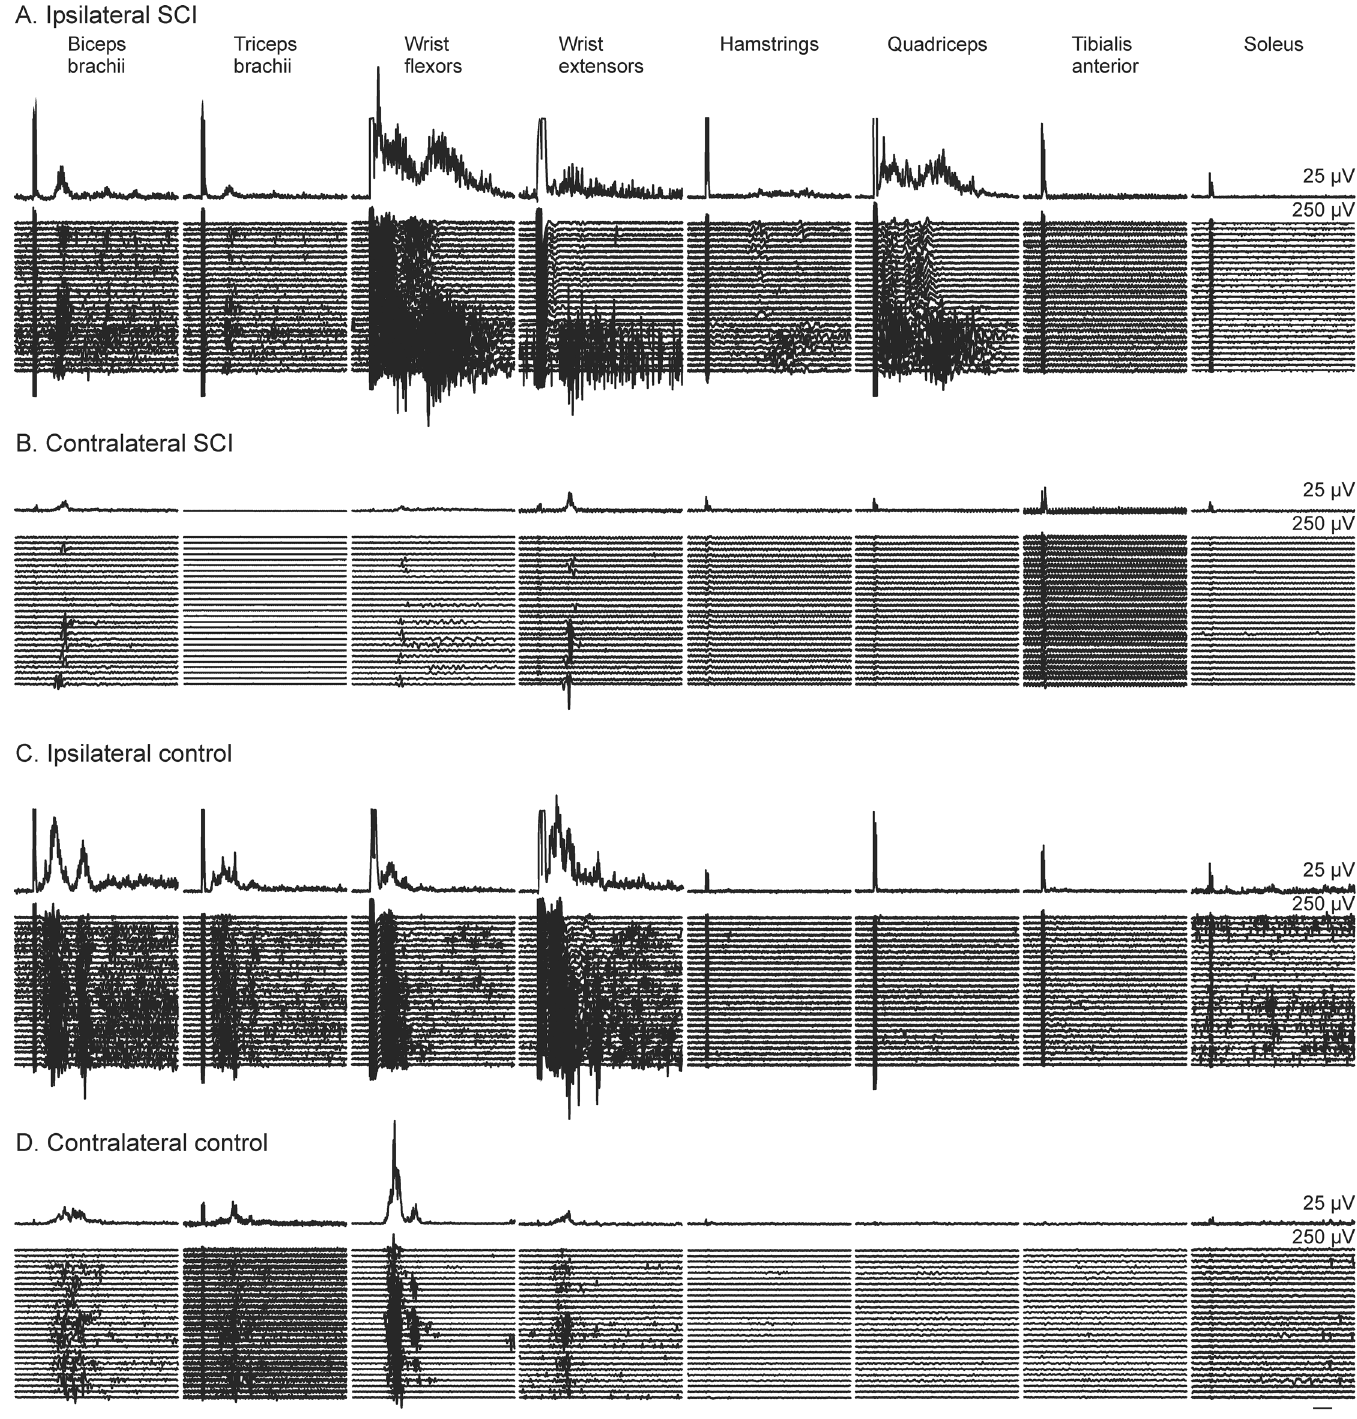
Fig 3. Interlimb and within-limb reflexes with RN stimulation. EMG evoked by radial nerve stimulation in 16 muscles (8 muscles recorded ipsilaterally, 8 contralaterally) of a participant with SCI (A,B) and one control participant (C,D). The top trace in each panel depicts the rectified averaged EMG from all of the trials of stimulation (n = 30) rastered below. Stimuli occurred at the onset of the stimulus artefact visible in each average.